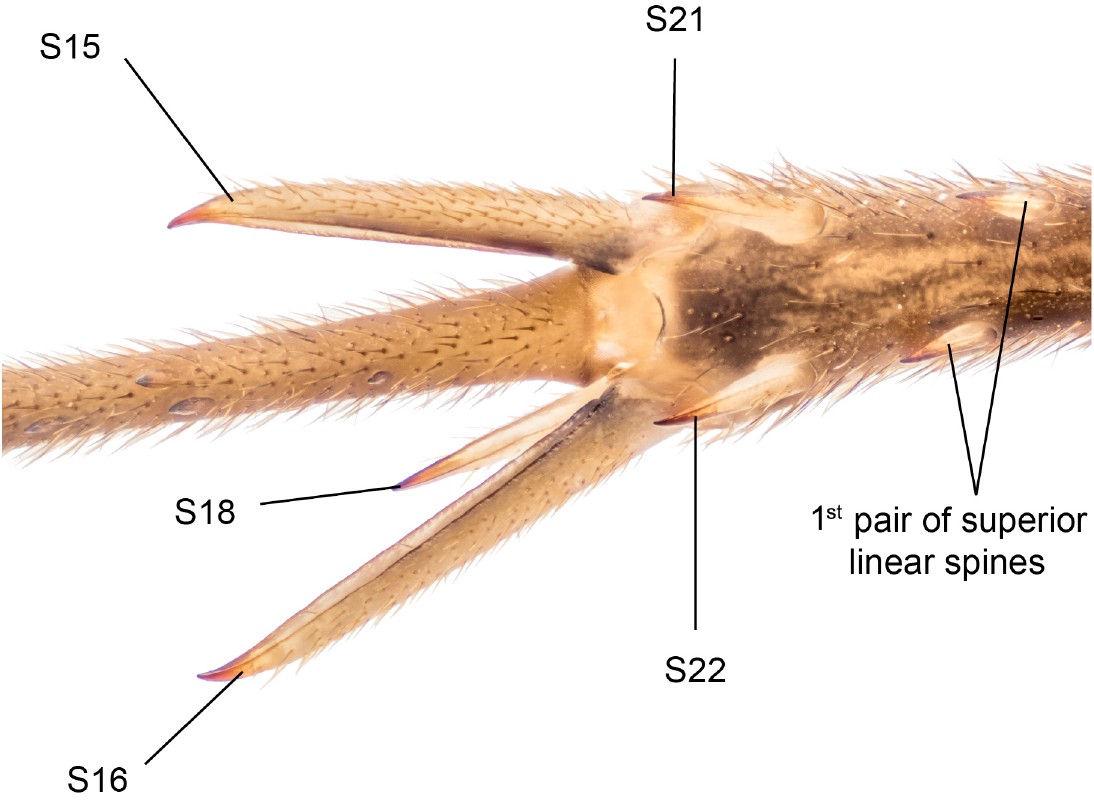
Fig. 2. Apical spines on the left hind tibia of Pleioplectron simplex hutton, 1896 (MPN Cw3459), numbered as in Fig. 1 (from Fitness et al . 2015). Dorsal view of posterior distal section of left hind tibia including part of first tarsal segment. Four pairs of ‘apical’ spines are commonly present: the inferior subapical pair S19 & S20 (not visible here); inferior apical pair S17 & S18 (S17 obscured here); superior apical pair S15 & S16; superior subapical pair S21 & S22. Some taxonomists have treated S21 & S22 as the first pair of superior linear spines, resulting in recording of three pairs of ‘apical’ rather than